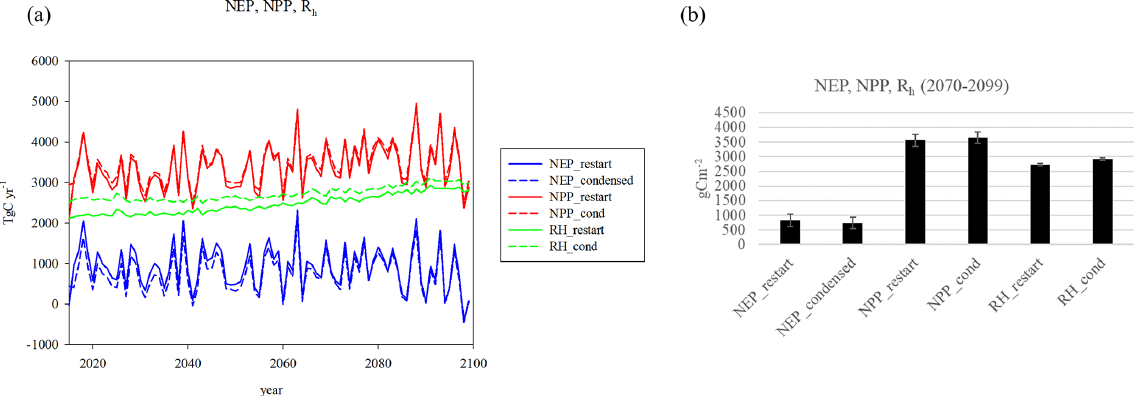
Figure 5. (a) Carbon fluxes (NEP, NPP, R h ) for the RESTART and CONDENSED runs, (b) mean differences 2070–2099 (no significant differences for either of the three